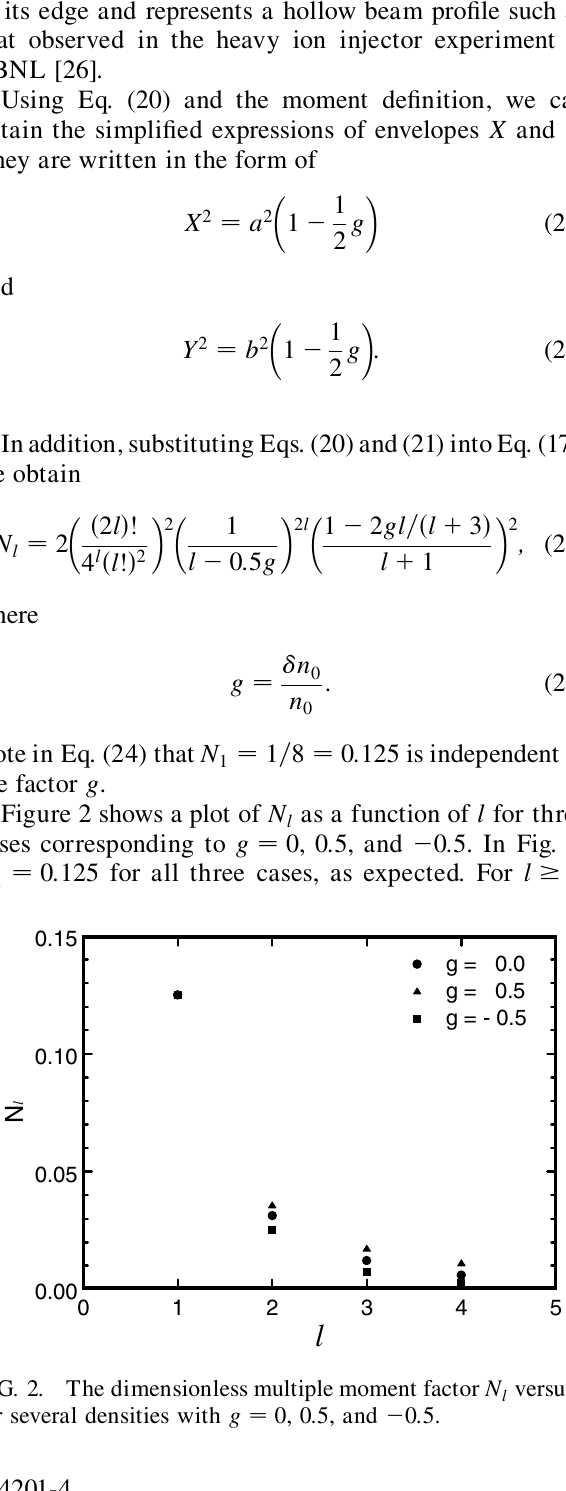
versus l FIG. 3. Plot of the normalized step-function lattice (cid:21) l versus normalized propagating distance s=S for + (cid:4) 0 : 5